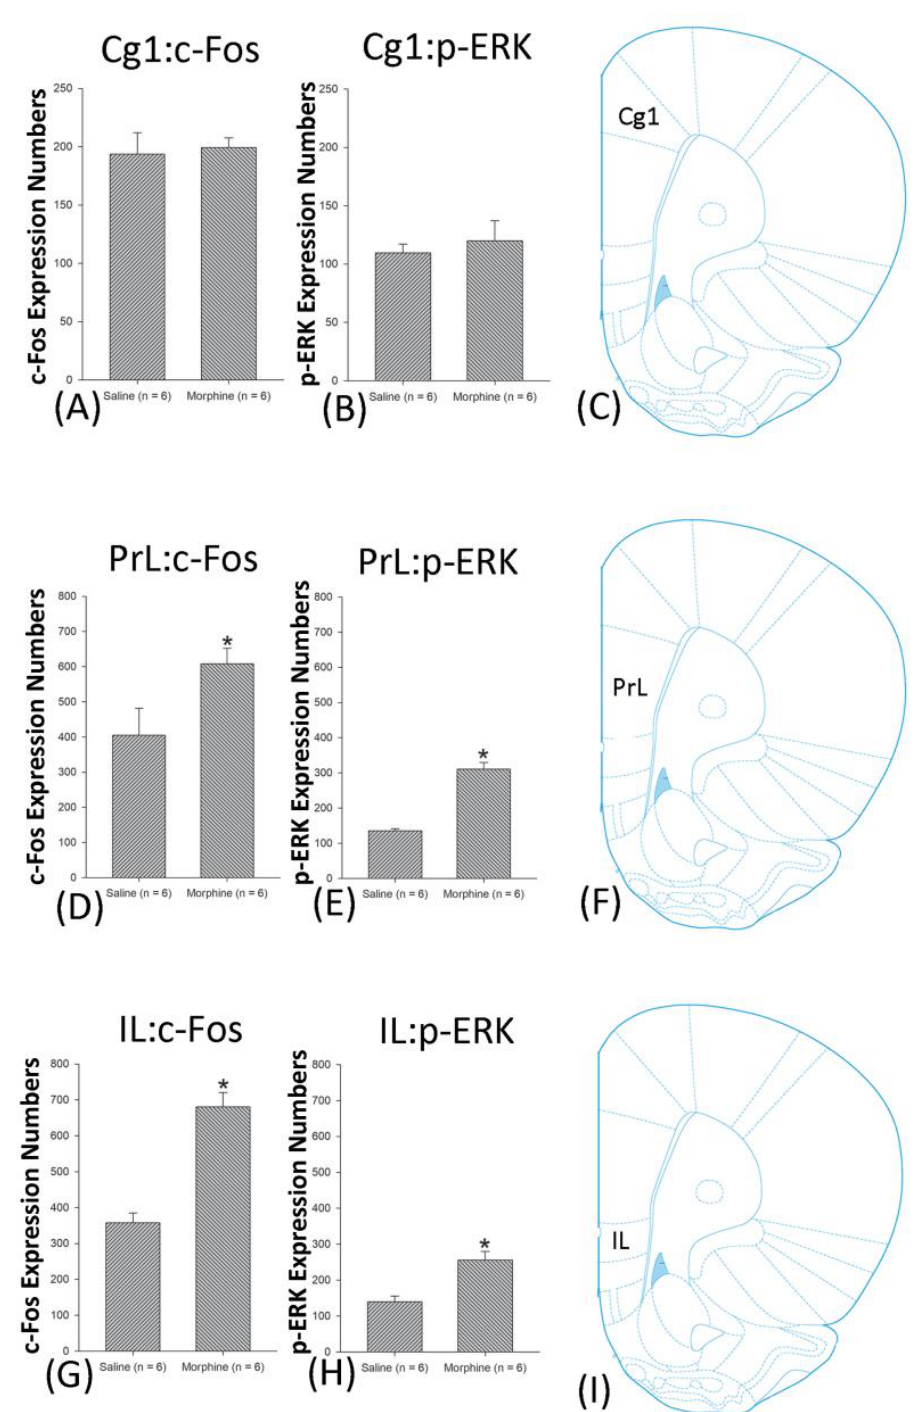
Figure 10. c-Fos and p-ERK expression in the extinction phase for the cingulate cortex area 1 (Cg1), prelimbic cortex (PrL), and infralimbic cortex (IL). ( A ) c-Fos and ( B ) p-ERK expression in the Cg1, ( D ) c-Fos and ( E ) p-ERK expression in the PrL, and ( G ) c-Fos and ( H ) p-ERK expression in the IL for extinction. ( C , F , I ) indicate a schematic representation of the Cg1, PrL, and IL. * p < 0.05 when comparing the saline and morphine groups ( n = 6 per group).